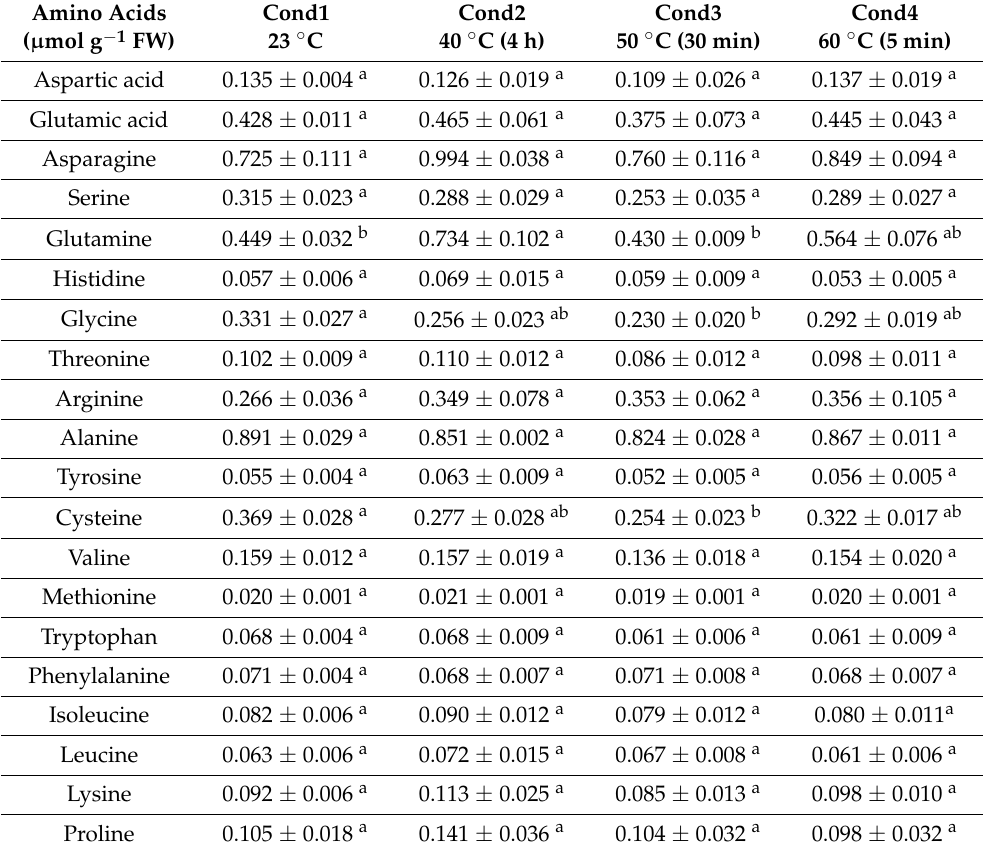
Table 3. Concentration of amino acids ( µ mol g − 1 FW) detected in P. halepensis EMs, collected at proliferation phase, induced under different